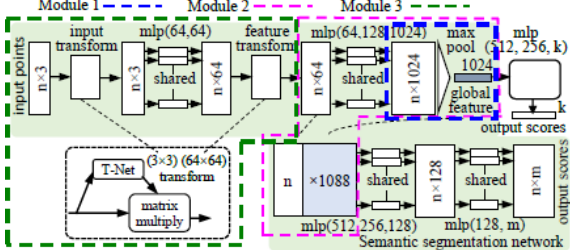
Figure 1. PointNet architecture, mlp stands for multilayer perceptrons, numbers in brackets are layer sizes; m and k are the number of classes. Figure curtesy (Qi et al.,